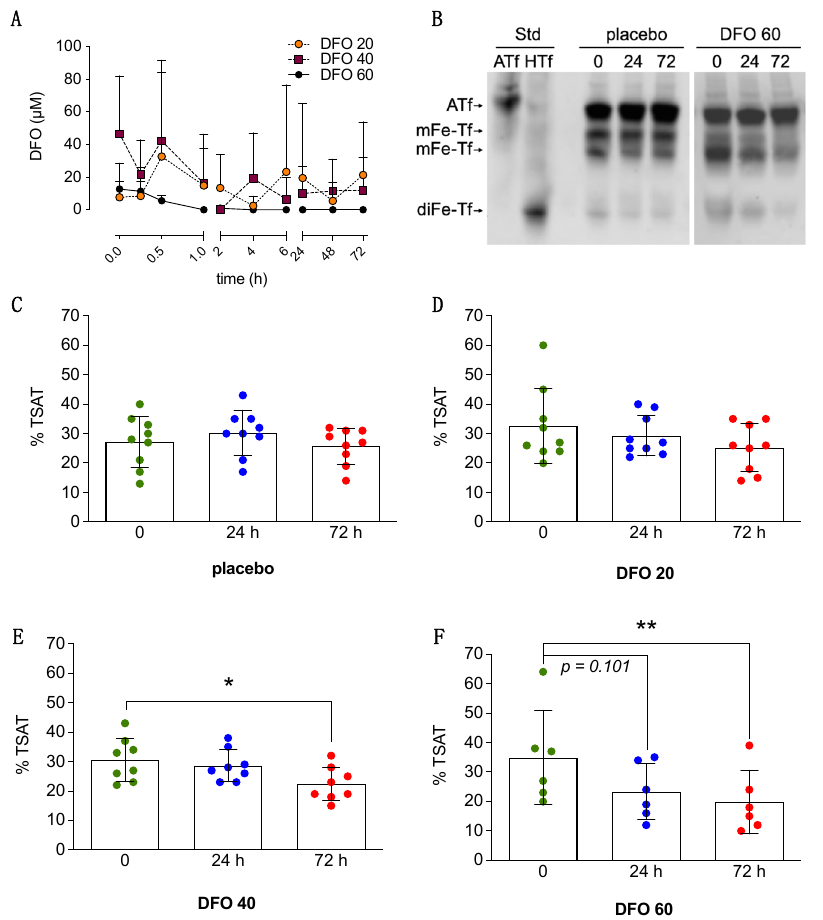
Figure 2. Deferoxamine (DFO) reduces TSAT time- and dose-dependently. ( A ) Time-course of serum DFO levels along the infusion in AIS patients treated with a 10 mg/Kg bolus of DFO IV followed by a 72 h continuous IV infusion of DFO in escalating dose tiers of 20, 40, or 60 mg/Kg/day (blood DFO levels at time = 0 of infusion in this graph are the result of the initial previous 10 mg/Kg bolus of DFO IV). Mean ± SD are shown; no significant effects were found (repeated measures ANOVA). ( B ) U-PAGE/WB depicting the bands of the iron-devoid form of human transferrin standard (Std) (apotransferrin, ATf) and human diferric transferrin (diFe-Tf) standard (holotransferrin, HTf). The iron load of transferrin determines the electrophoretic mobility of the different Tf forms in these urea gels. Arrows indicate the different electrophoretic pattern of ATf, the two monoferric forms of transferrin (mFe-Tf), and the diferric transferrin (diFe-Tf) form in serum samples of stroke patients. Placebo and DFO depict bands of transferrin of two representative patients (one of the placebo group and one of the DFO 60 group) before the onset of treatment (0), and 24 and 72 h after administration. In each lane, optical density of the bands allow calculation of the % TSAT for a given patient at a given time point using the formula: TSAT (%) = (0.5 *mFe·Tf + diFe·Tf)*100/(ATf + mFe·Tf + diFe·Tf). ( C – F ) % TSAT before the onset of treatment (0 h), and 24 and 72 h after administration of placebo ( C ), 20 mg/Kg/day DFO ( D ), 40 mg/Kg/day DFO ( E ), or 60 mg/Kg/day DFO ( F ). Values are presented as mean ± SD. * p ≤ 0.05, ** p ≤ 0.005 (repeated measures one-way ANOVA plus the post-